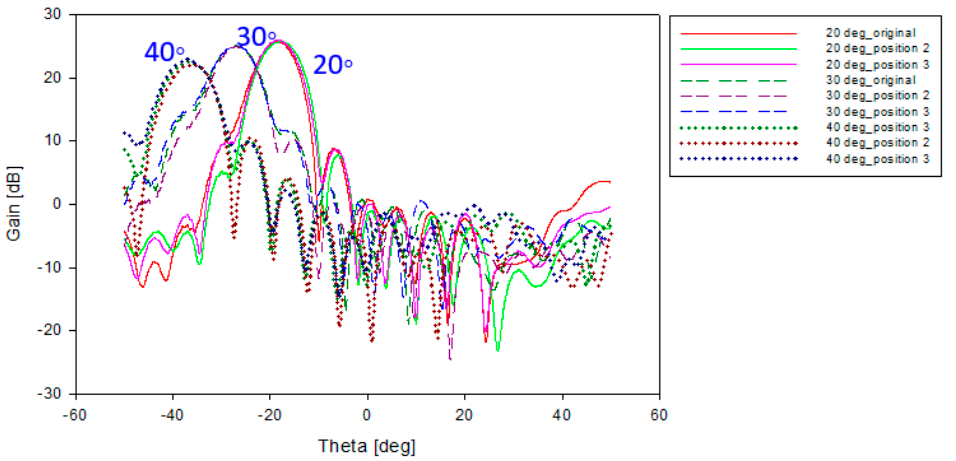
Figure 26. Antenna gain for all feed position for energy conservation lens.